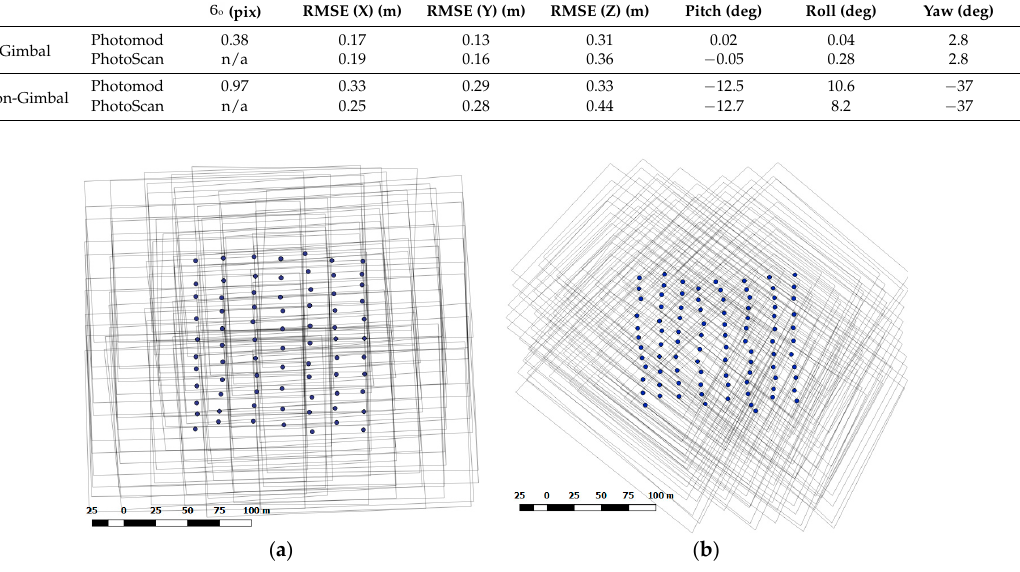
Figure 4. The block schemes (imagery footprints and projection centers) of two unmanned aerial systems (UAS) flights based on block adjustment results ( Photomod ) ( a ) with gimbal, and ( b ) without